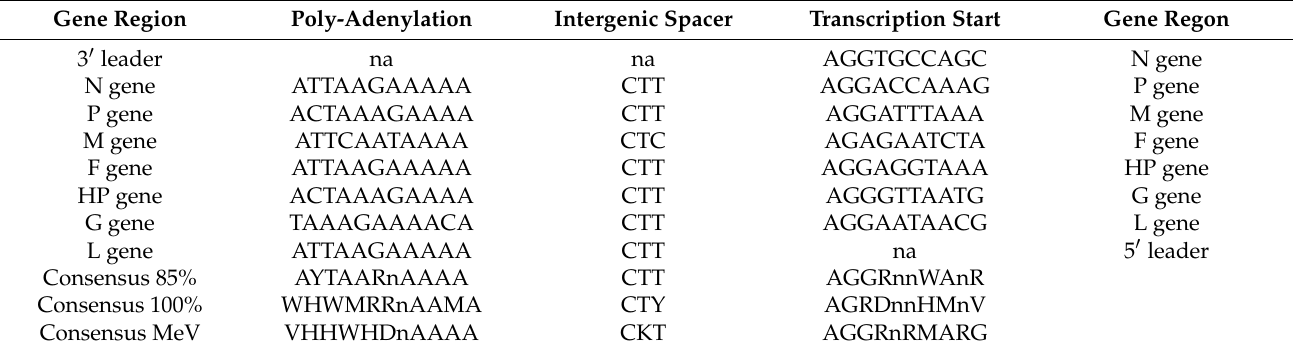
Table 1. Predicted intergenic regions of